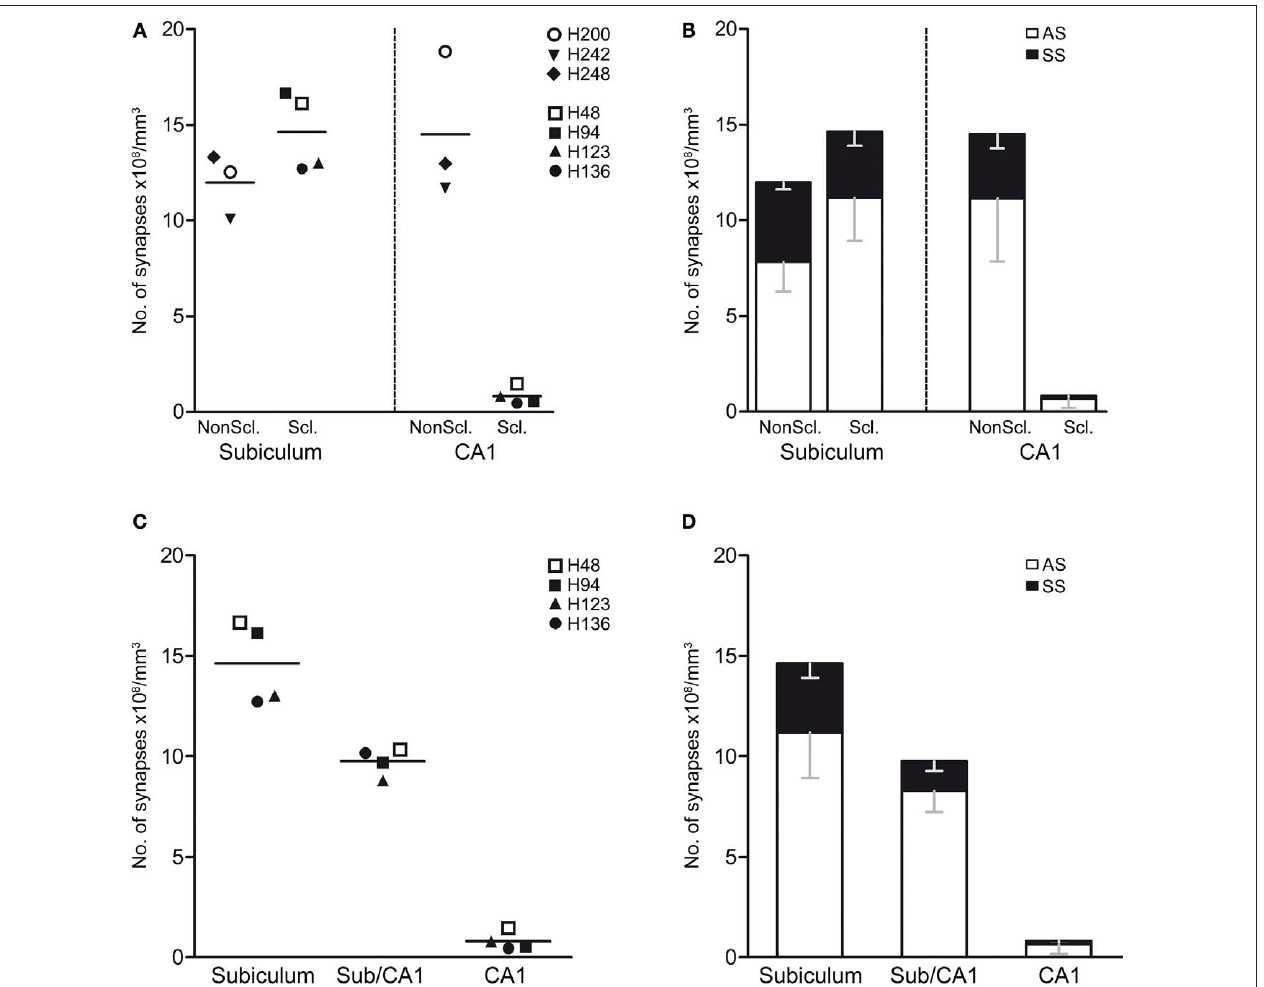
hippocampus. (C) Graph illustrating the overall synaptic density. Individual points indicate the average values obtained in each case examined. (D) Graph of the synaptic density (mean ± SD) according to the type of synapse and region. The statistical comparisons are shown in Table 3 . Non-sclerotic hippocampus (patients H200, H242, and H248); sclerotic hippocampus (H46, H94, H123, and H 136). See Table 1 for clinical details. AS, asymmetric; SS, symmetric.